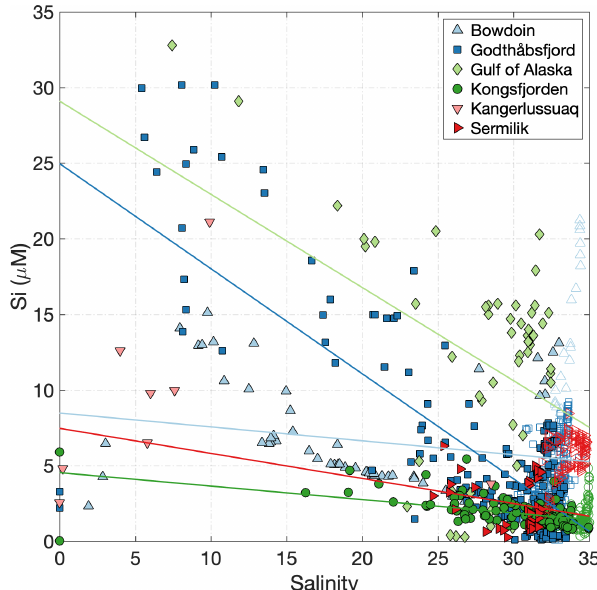
Figure 4. Dissolved Si distribution vs. salinity for glaciated Arc- tic catchments. Data are from Bowdoin Fjord (Kanna et al., 2018), Kongsfjorden (Fransson et al., 2016; van de Poll et al., 2018), Ser- milik Fjord (Cape et al., 2019), Kangerlussuaq (Hawkings et al., 2017; Lund-Hansen et al., 2018), Godthåbsfjord (Hopwood et al., 2016; Meire et al., 2016b), and the Gulf of Alaska (Brown et al., 2010). Linear regressions are shown for large surface datasets only. Linear regression details are shown in Table S1. Closed markers in- dicate surface data ( < 20m depth), and open markers indicate sub- surface